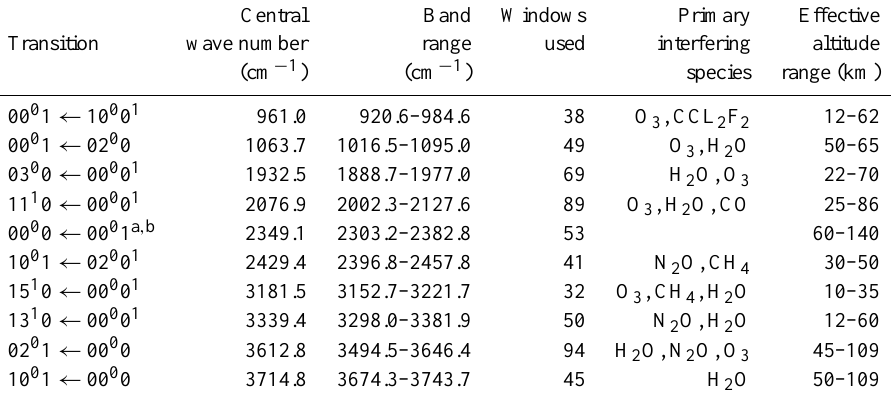
Table 1. List of CO 2 vibration–rotation bands used in T − P analysis. Each band’s central wave number is given by Rothman et al. (1992) and the range is of the micro-windows used, which are predominantly between 0.2 and 0.32cm − 1 . Interfering species are gases with absorption lines occupying the micro-windows, but are also fitted by GGG. The effective altitude range is that over which absorption lines are strong enough relative to noise to be fitted, but not so strong that absorption is total over the range of the micro-window, and where the micro-window is not dominated by strong absorption by interfering species.